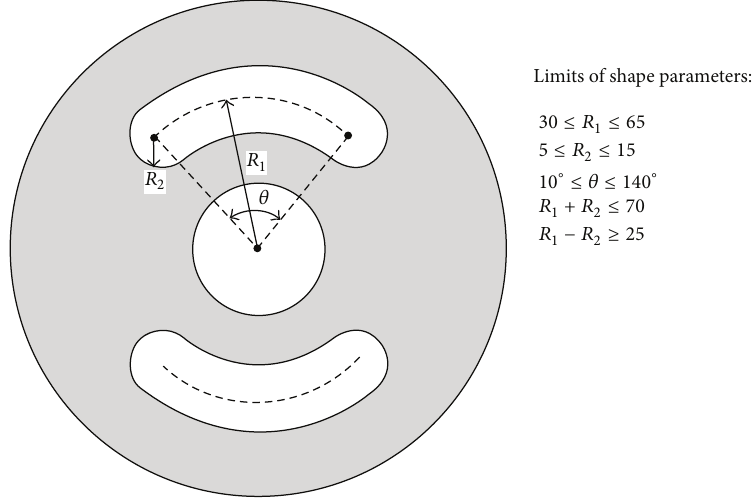
Figure 2: 2D rubber parametric model and limits of shape